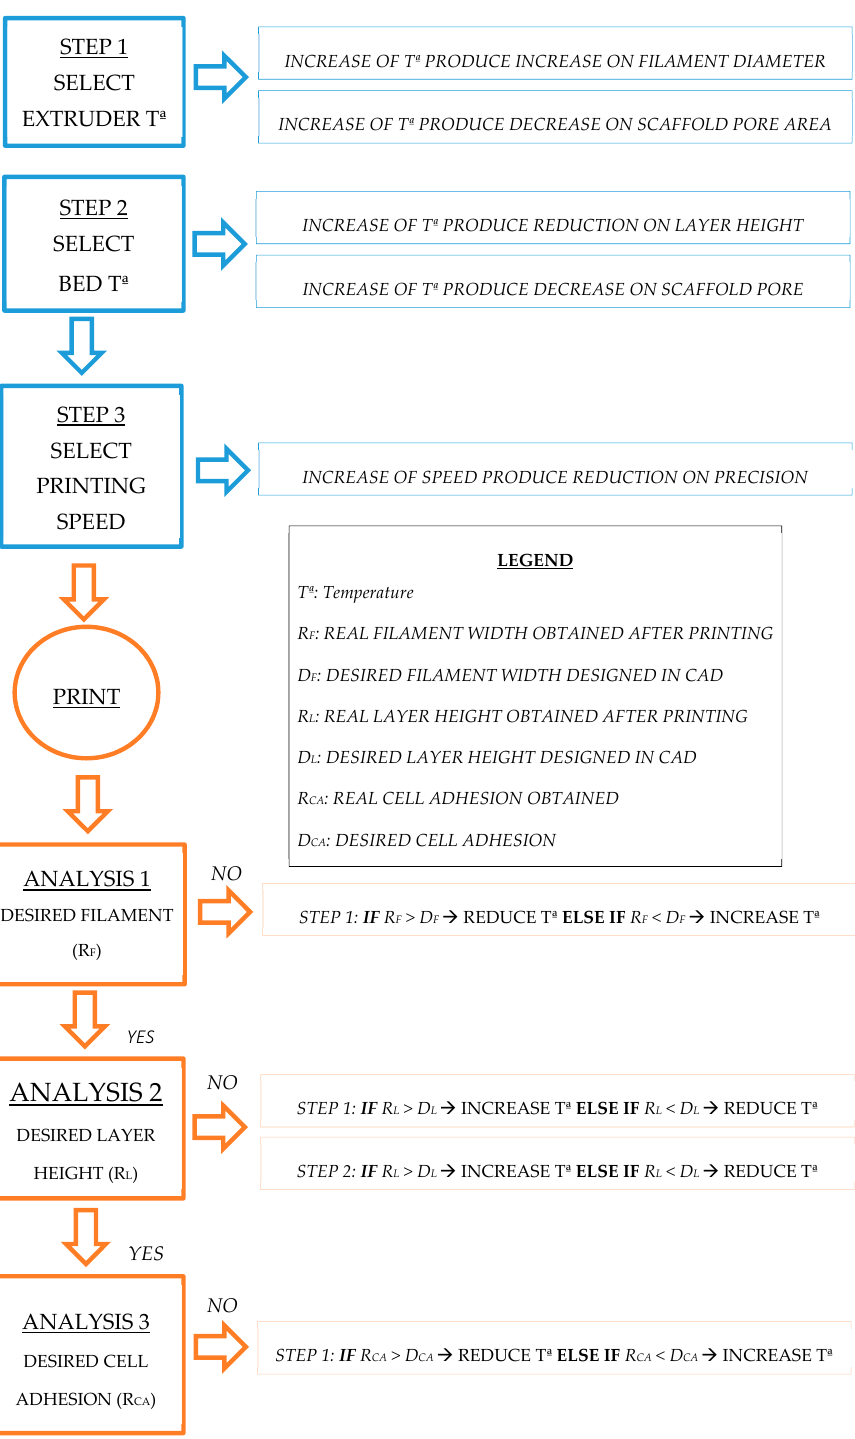
Figure 3. Flowchart of process parameter optimization. Every parameter consists of the values tested and, on the right, the corresponding measurable variable for new cell cultures. Fabrication parameters are in the left column and design parameters in the right.